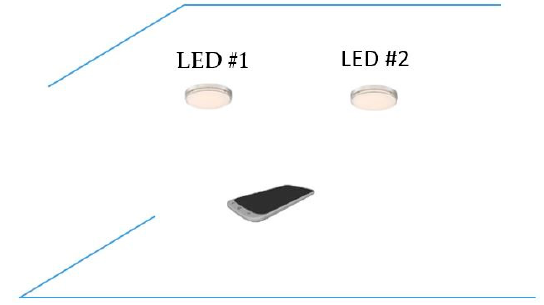
Figure 26. Distance estimation scenario.